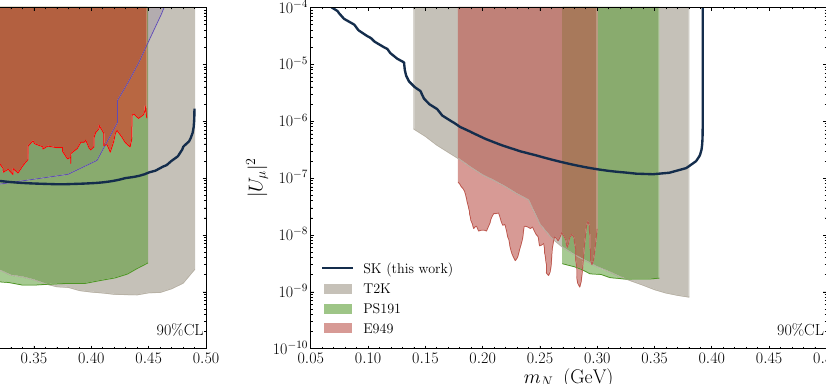
Fig. 3 SK constraints on the minimal HNL scenario at 90% CL, pro- jected onto the plane | U e | 2 vs m N (for U μ,τ = 0). Our results (solid black lines) are compared to corresponding limits obtained for the